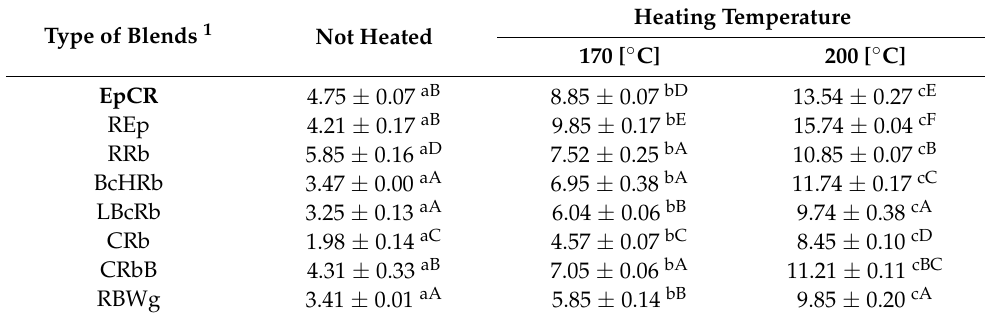
Table 4. Changes of total polar compounds (TPC) during heating oil blends